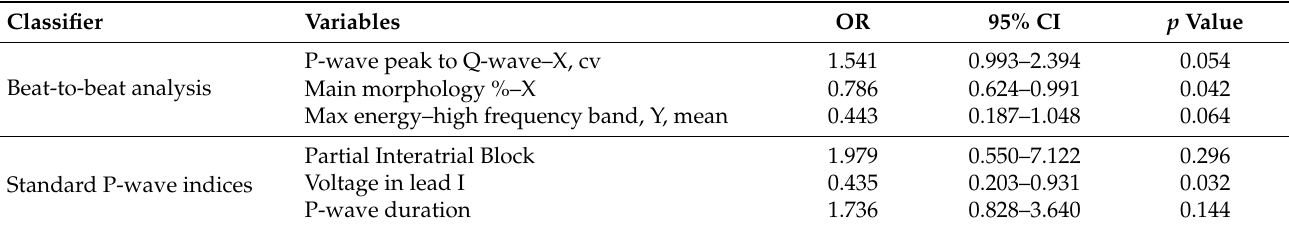
Table 5. Multivariate analysis characteristics of logistic regression-based classifiers.